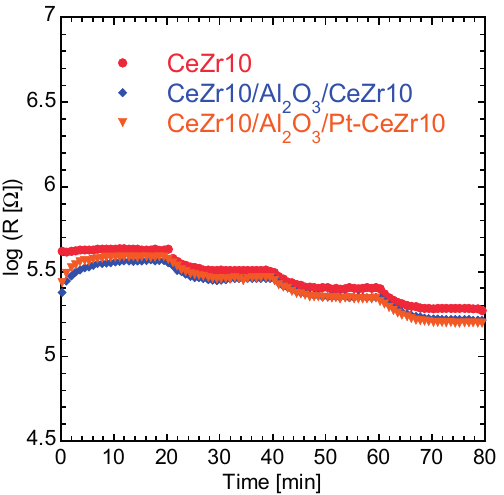
Figure 4. Dynamic resistance response of CeZr10, CeZr10/Al 2 O 3 /CeZr10, and CeZr10/Al 2 O 3 /Pt-CeZr10 thick films to oxygen. The concentrations of oxygen used were 100, 30, 10, and 3% in